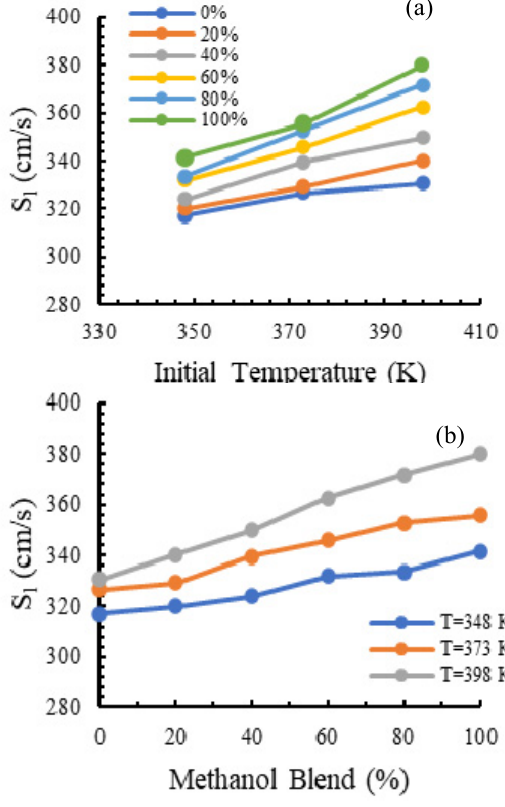
Figure 13. Unstretched flame propagation speed for stoic– hiometric mixtures versus (a) initial temperature (b) metha– nol blending